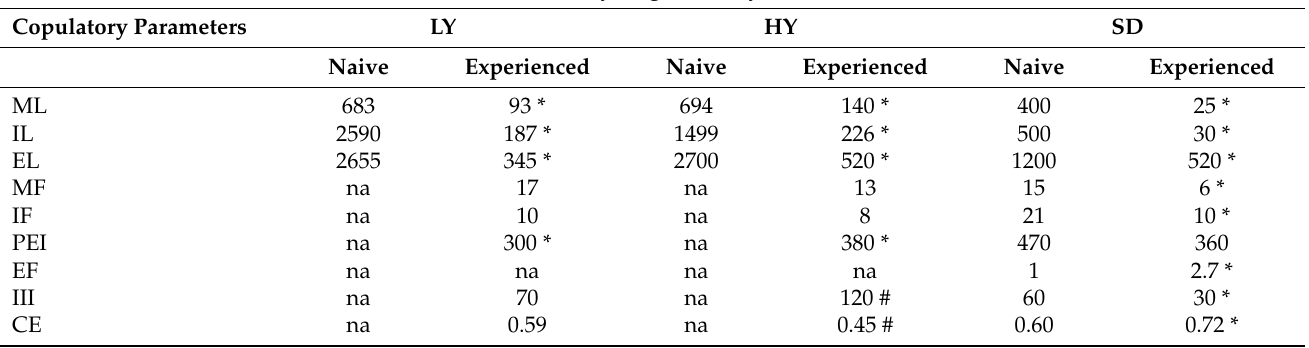
Table 14. Mean values of copulatory parameters of the first series of copulatory activity of male LY/HY rat sub-lines at the first copulatory test with a receptive female rat (sexually naïve condition) and after at least 5 copulatory tests (sexually experienced condition): comparison with genetically heterogeneous Sprague-Dawley (SD) rats. Psychogenetically Selected Rat